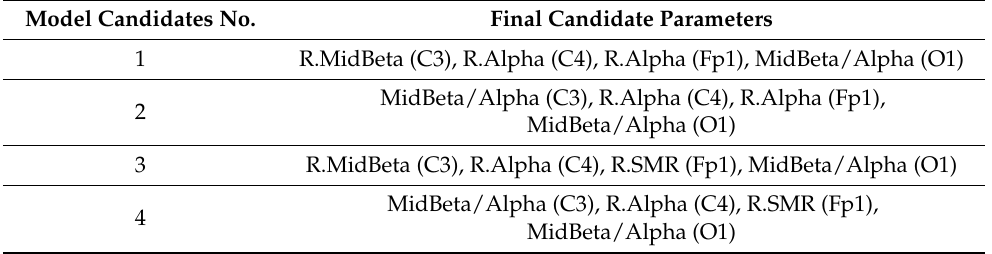
Table 6. Four sets of parameters were selected without violating multicollinearity. Model Candidates